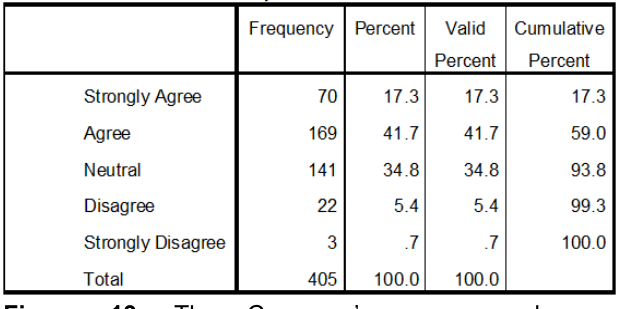
13. The Company’s revenues have